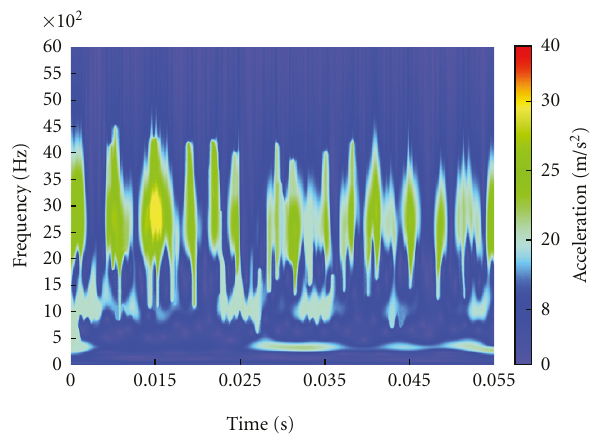
Figure 6: Frequency scalogram of square wavelet coe ffi cient of the gear unit with a gear with a crack in a tooth root.